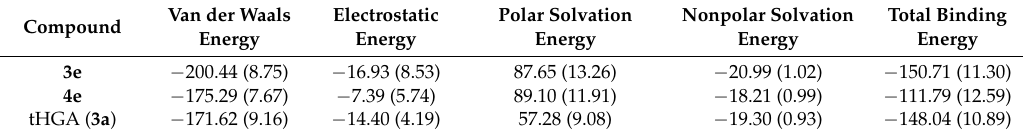
Table 3. Summary of binding free energy ( ∆ G bind ) for compounds 3e , 4e and tHGA ( 3a